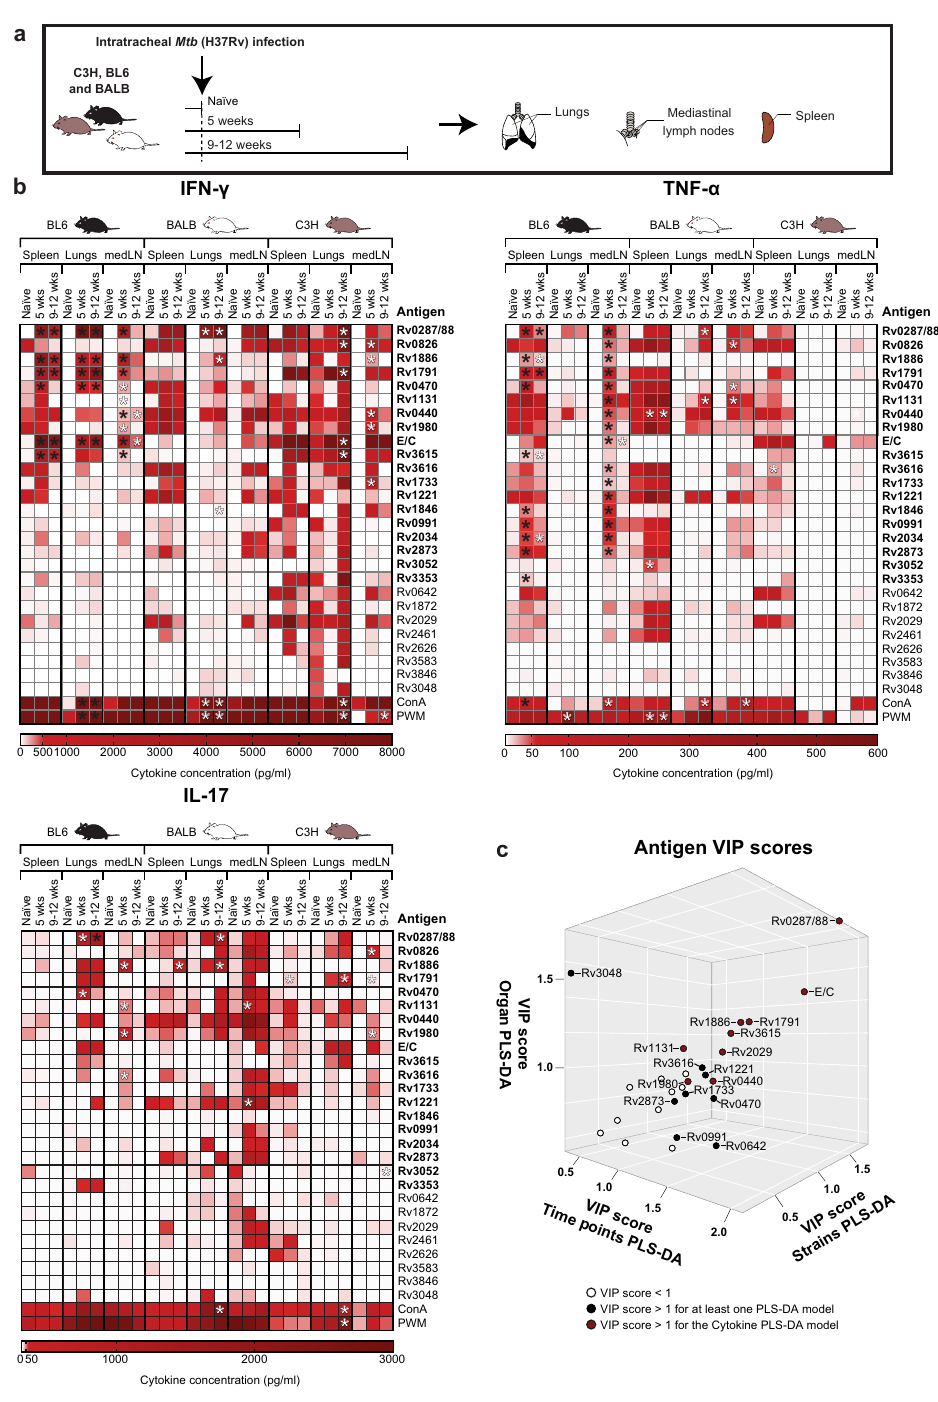
Fig. 1 Most IVE-TB antigens are recognised by cells from Mtb infected mice with differences among mouse strains, organs and cytokines. a C57BL/6 (BL6), BALB/c (BALB) and C3HeB/FeJ (C3H) mice were challenged with 1 × 10 4 CFU Mtb -lux strain intratracheally and killed at an early (5 weeks) or later (9 – 12 weeks) stage of Mtb infection. Uninfected naïve control mice were killed and tested in parallel. Pooled cells from lungs, mediastinal lymph nodes (medLN) or spleens were stimulated with single or fusion Mtb antigens or with positive control stimuli ConA and PWM. The concentrations of IFN- γ , TNF- α and IL-17 were measured in the cell supernatants after 3 days of stimulation and corrected for background. b Heatmaps of the speci fi c Mtb antigen responses for each cytokine are shown. Colour gradients indicate the cytokine concentration, while asterisks indicate signi fi cant differences between the naïve and the Mtb challenged groups. White * p -value < 0.05, computed with Kruskal – Wallis test; black asterisk marks differences that remained signi fi cant after multiple test correction ( q -value < 0.1, i.e., FDR-adjusted p -values of Mann – Whitney.test). c 3D plot of the Variable Importance in Projection (VIP) scores obtained from each PLS-DA model computed on the basis of the following known classes: (i) time points (i.e., naïve mice vs. mice killed at early or late point after Mtb infection); (ii) mouse strains (i.e., C57BL/6 (BL6), BALB/c (BALB) and C3HeB/FeJ (C3H) mice); (iii) organs (i.e., lungs, mediastinal lymph nodes or spleens); (iv) cytokines (i.e., IFN- γ , TNF- α and IL-17). Antigens with a VIP score >1 were considered to have an above average in fl uence on the model and are depicted by solid dots. Antigens with a VIP score >1 for the cytokine PLS-DA model are depicted by solid red dots. Antigens with a VIP score <1 are depicted by empty dots and their names are omitted in the 3D